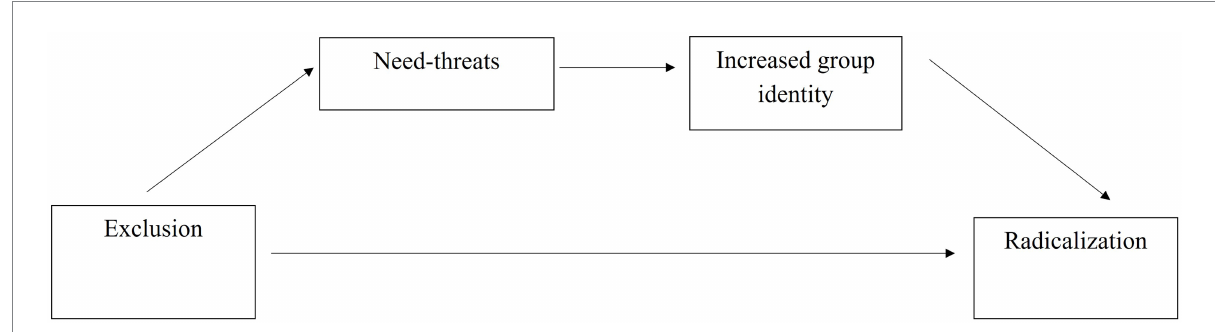
FIGURE 1 A conceptual model of the mediating pathway of need-threats and activist group identity between the effect of exclusion on willingness to participate and endorse